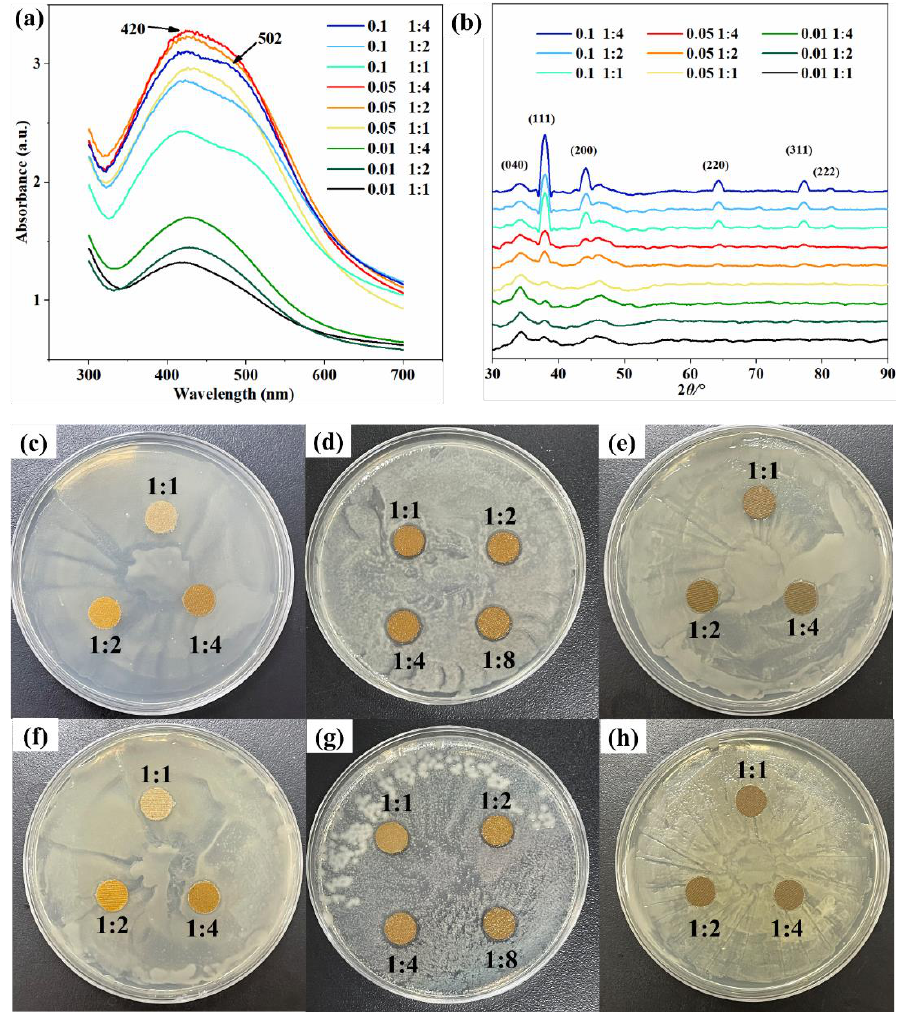
Figure 5. UV absorption spectra ( a ), XRD ( b ). The inhibition zone of E. coli ( c – e ) and S. aureus ( f – h ). AgNO 3 concentrations were 0.01 mol/L ( c , f ), 0.05 mol/L ( d , g ), and 0.1 mol/L ( e , h